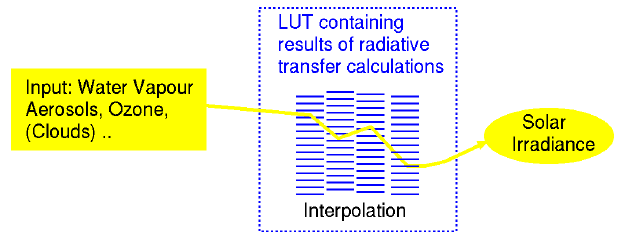
Figure 1. The principle of an LUT approach. The transmission is pre-calculated for a variety of atmospheric states with a radiative transfer model (RTM) and saved in a lookup table (LUT). The LUT is then used to determine SSI based on the input given for the atmo- spheric state for each pixel and time step by